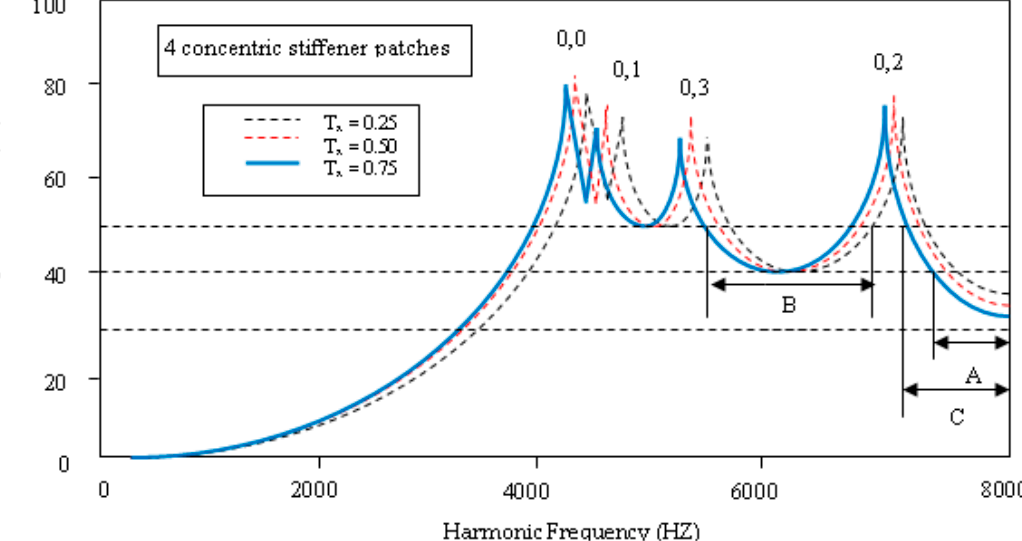
Figure 15. Numerical comparison of sound power level for annular plate attached with 4 concentric stiffener patches and having parabolic decreasing thickness variations (Case I) for different taper ratios T x .